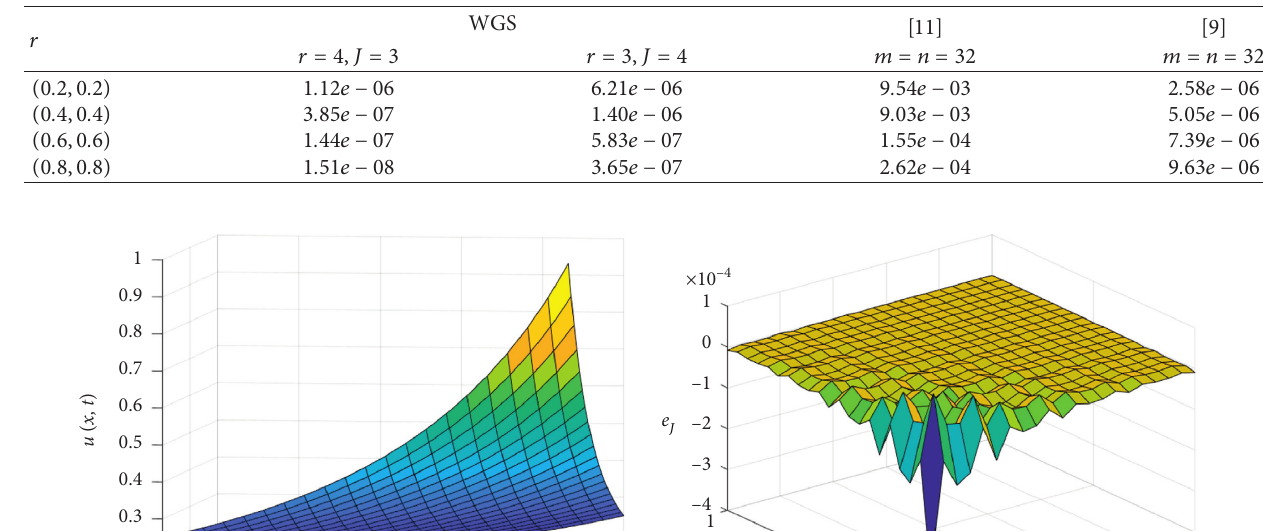
Table 1: Comparison of maximum absolute value error with others for Example 1.